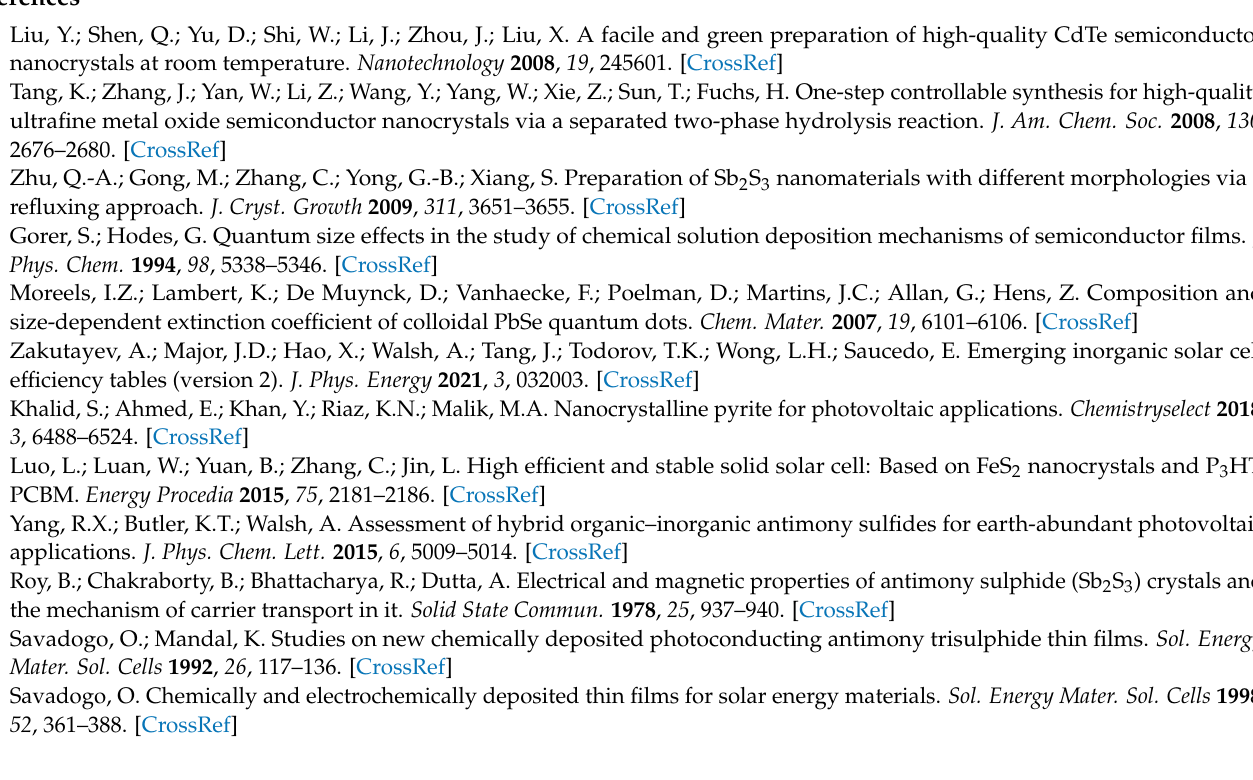
Figure S2: P-XRD patterns of FeS nanoparticles at (a) 300 ◦ C, (b) 400 ◦ C (c) 450 ◦ C and (d) 475 ◦ C from decomposition of Fe(S 2 CN(Et 2 )) 3 using melt method for 1h. All peaks corresponded to